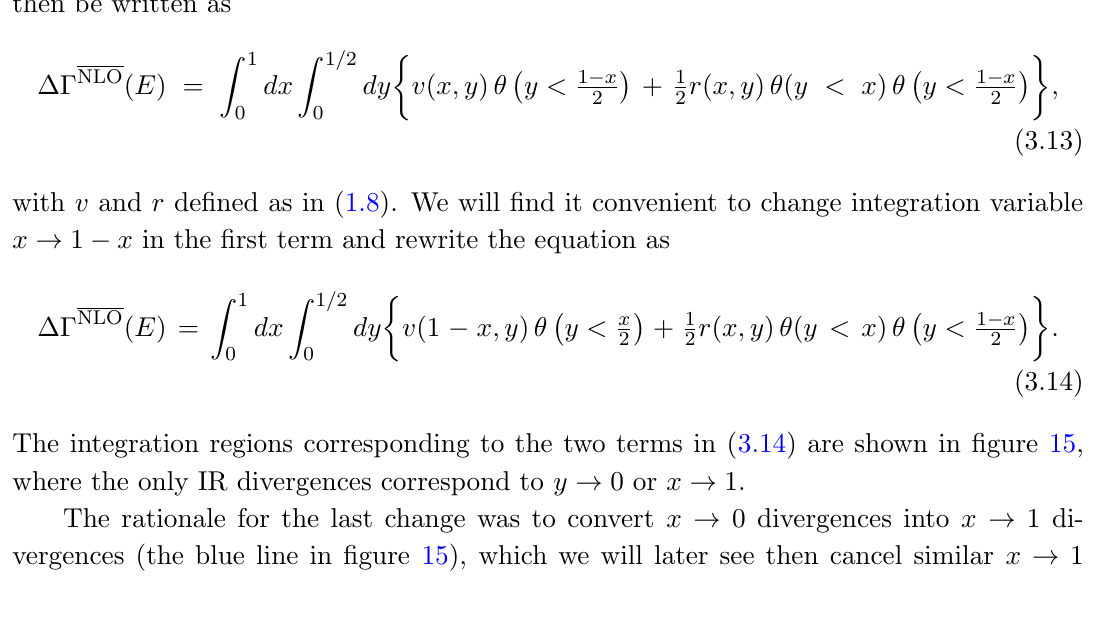
Figure 15 . The integration regions in (3.14). The labels (a,b,c) and (d) correspond to the original origin of these terms in (cid:12)gure 13. Colored lines again denote limits of integration associated with IR divergences. Power-law divergences associated with the red lines above cancel each other in (3.14). Blue line divergences only cancel when loss and gain terms are combined in (3.16c). The origins of the red vs. blue divergences here are depicted by the red vs. blue lines in (cid:12)gure 13. depicted by the shaded region of (cid:12)gure 15d. [We will see later the advantage of integrating over these two regions instead of reducing the integral to just one region.] Eq. (3.12)